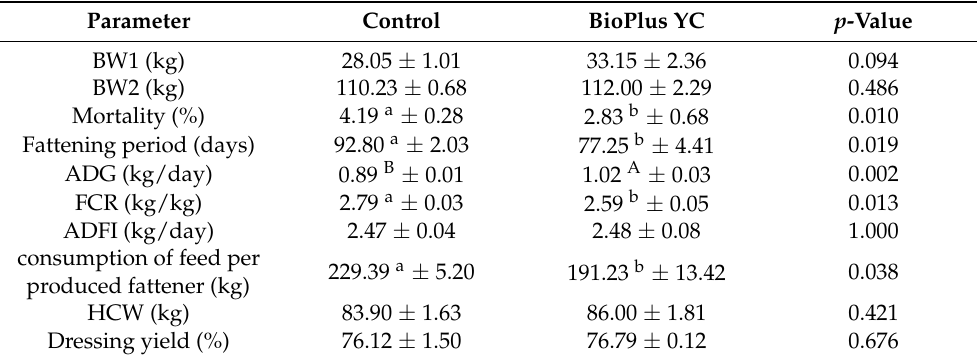
Table 2. Results of fattening and slaughtering performance from Pig Production Management System (Cloudfarms).